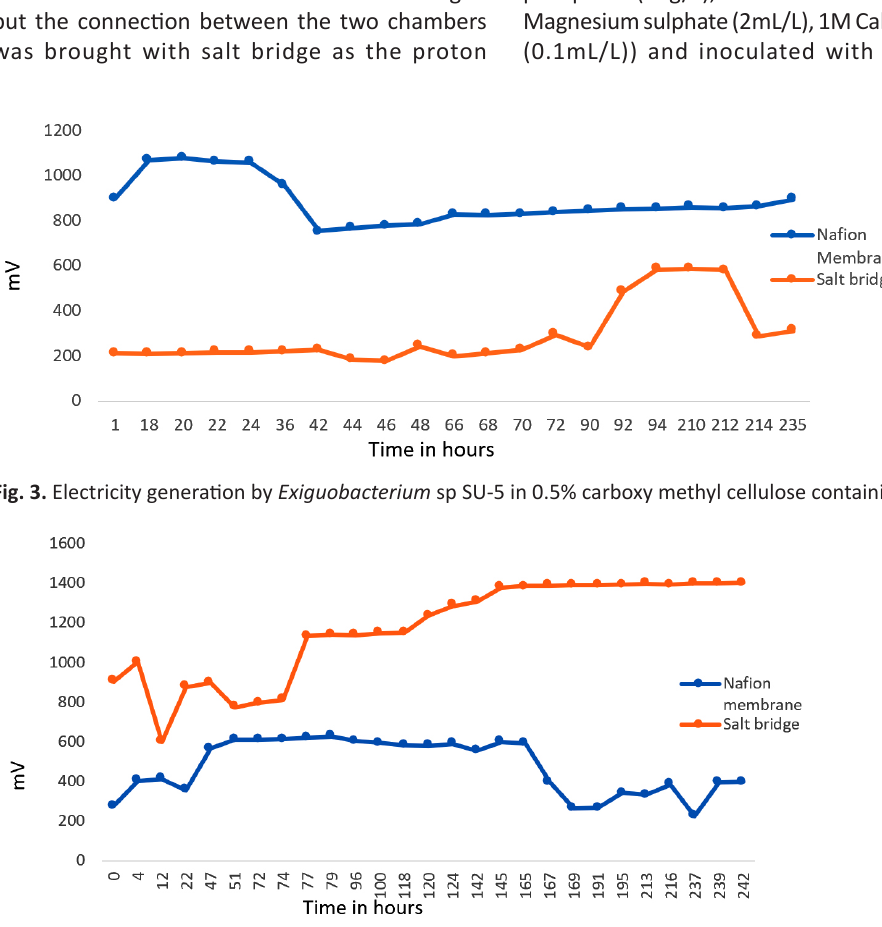
Fig. 4. Electricity generation by Exiguobacterium sp SU-5 in 1 % carboxy methyl cellulose containing medium